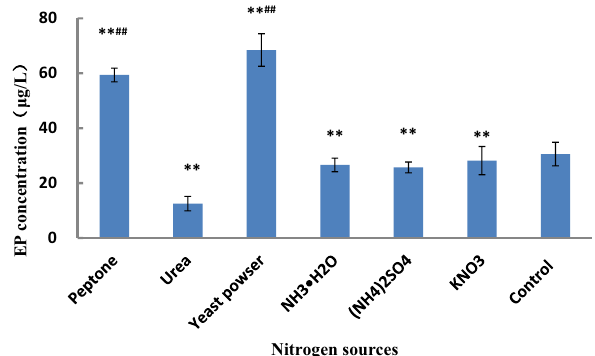
Figure 2. Effect of nitrogen sources on the EP concentration. The control was the medium without nitrogen sources. ** p ≤ 0.01, compared with the control group; ## p ≤ 0.01, compared with the groups using NH 3 ∙H 2 O, (NH 4 ) 2 SO4, and KNO 3 as nitrogen sources, respectively. The other components of the medium were the same, and the culture was carried in a rotary shaker at 25 °C and 120 rpm for 48